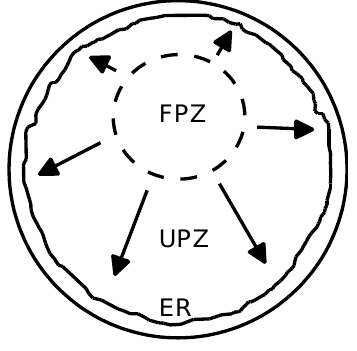
Figure 6. Scheme of the different fracture regions in the steels: fracture process zone, FPZ; unstable propagation zone, UPZ; external ring, ER.